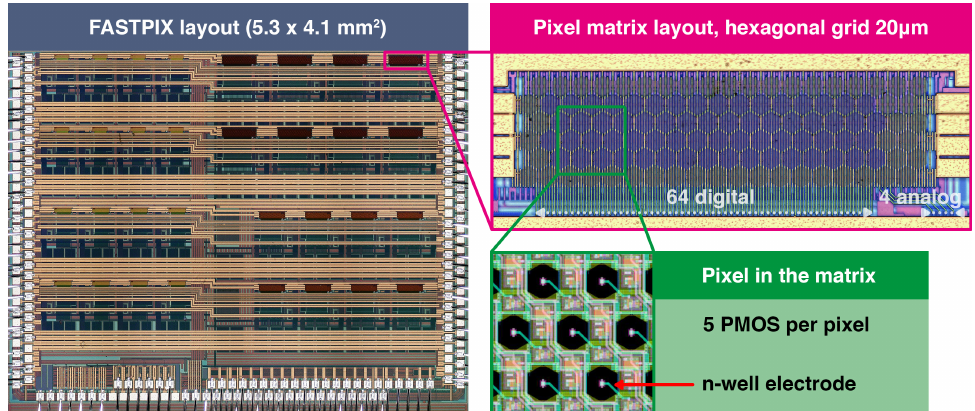
Figure 2. FASTPIX layout (5.3mm × 4.1mm) with details of the 20µm pitch hexagonal grid and zoom on 7 pixels.